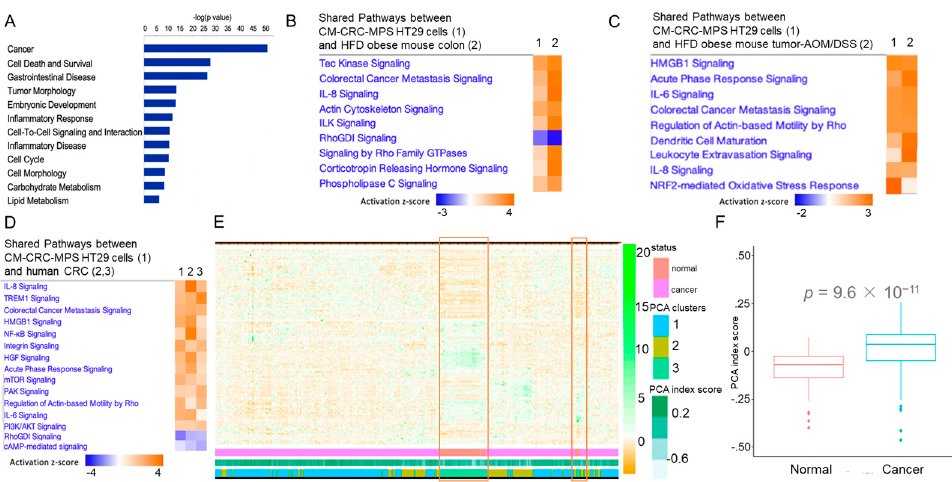
Figure 3. ( A ) Top diseases representing differentially expressed genes (DEGs) in colon cancer HT29 cells mediated by CM from CRC-MPS from obese patients relative to control ( p < 0.05, IPA). ( B , C ) Top canonical pathways representing these DEGs compared to DEGs from colon and colonic tumors (AOM/DSS) of HFD obese mice ( n = 3 for each group, FC > |1.5|, FDR < 0.05, IPA). In ( B ), Column 1 contains pathways representing DEGs in HT29 cells treated with CM from CRC-MPS (vs. ESC), and Column 2 contains pathways in HFD obese mouse colon (vs. RD colon). In ( C ) Column 1 contains pathways representing DEGs in HT29 cells treated with CM from CRC-MPS (vs. ESC), and Column 2 contains pathways in HFD obese mouse tumors (AOM/DSS model vs. RD normal colon). ( D ) Shared pathways representing DEGs from HT29 cells treated with CM from CRC-MPS (Column 1) and human colon cancer relative to normal colon (Column 2, GSE4183, n = 23; Column 3, GSE141174, n = 198; fold change > |1.5|, FDR < 0.05, IPA). ( E , F ) Unsupervised hierarchical clustering and heatmap showing hOEC 867 signature separating transcriptome of colon cancer samples from normal. Orange boxes highlight normal samples. Principal Component Analysis (PCA) of hOEC 867 signature and significance of PCA index score (TCGA), normal colon ( n = 41), and tumors ( n = 457). Finally, we validated selected obese EPAT-mediated DEGs for expression in HT29 cells treated with CM from obese CRC-MPS vs. ESC (Figure 4A). Transcriptional levels of these genes were similarly altered in the human colon cancer samples relative to